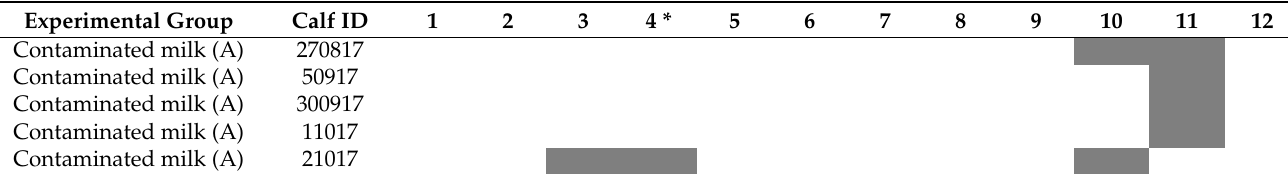
Table 2. Fecal shedding pattern of MAP in the 4 groups of calves during the 12-month study. A solid dark gray box indicates a positive fecal culture confirmed by IS900-specific qPCR; a white box indicates a negative culture. Time after challenge